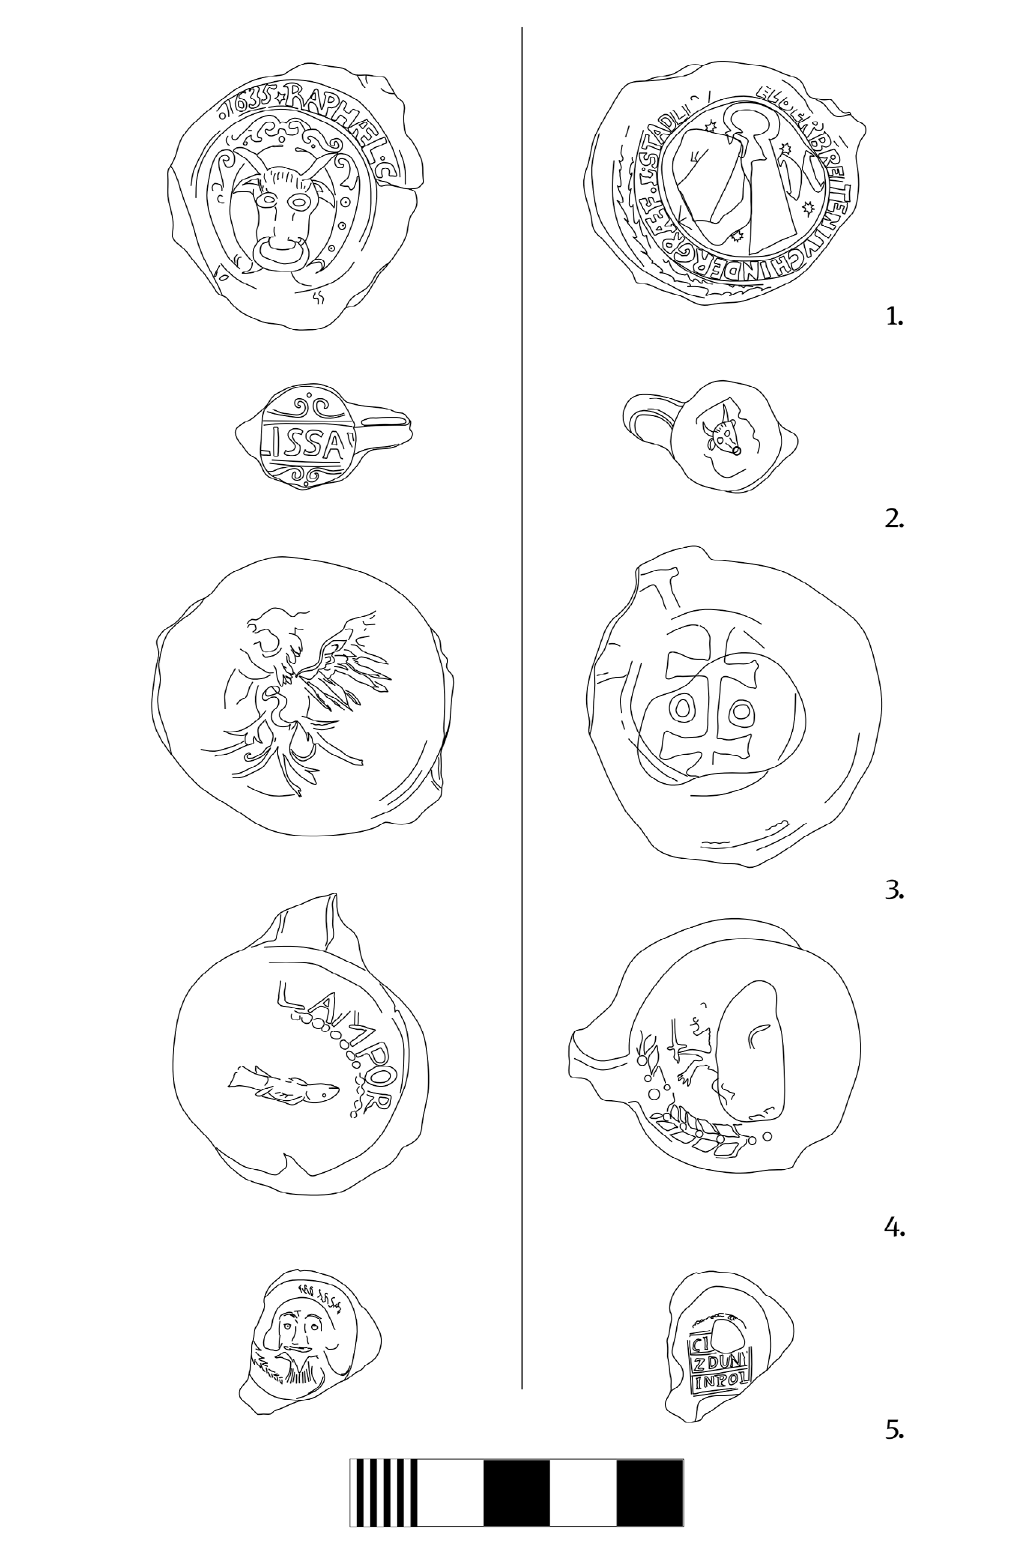
Figure 25. Lead seals originated from Leszno (1, 2), Wschowa (3), Lampartopol (4), Nowe Zduny